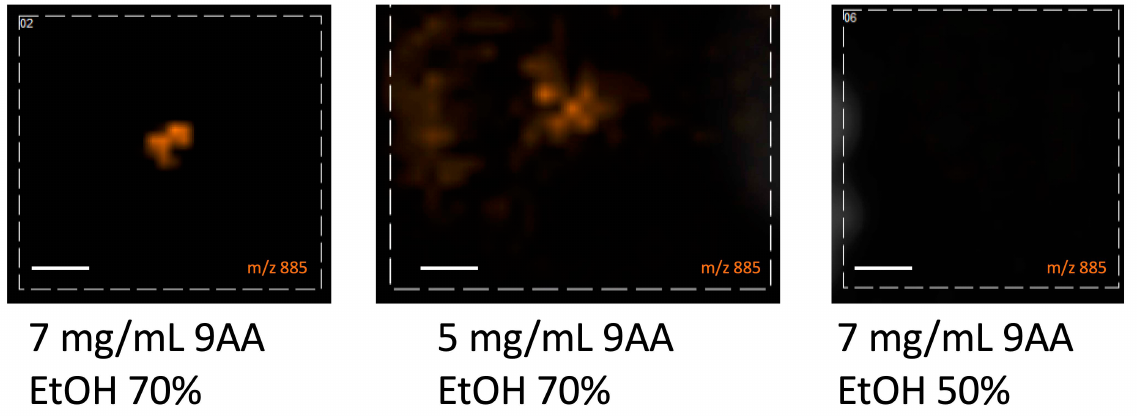
Figure 12. The picture of the oocyte obtained after covering them with the matrix of different concentrations and solvent compositions—negative ionization mode, size bar: 200 µ